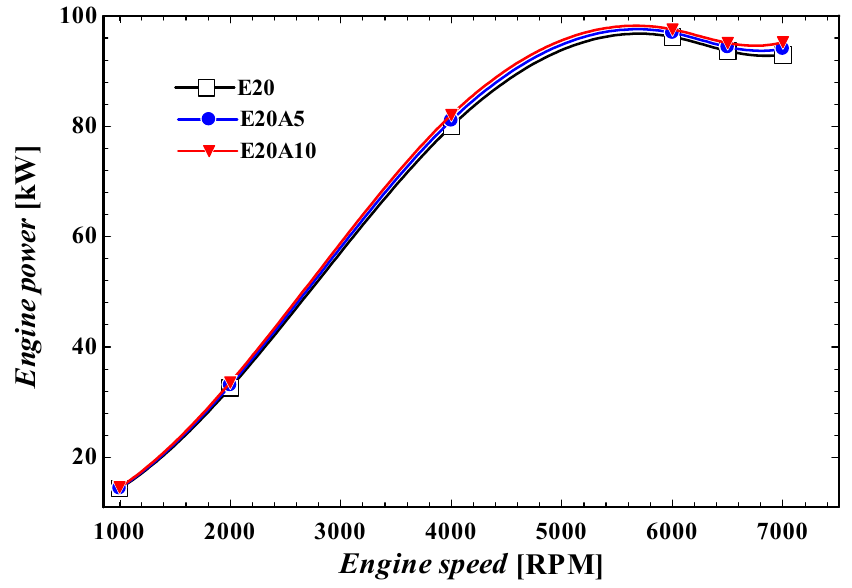
Figure 6. Engine power at various engine speeds at different fractions of ammonia.